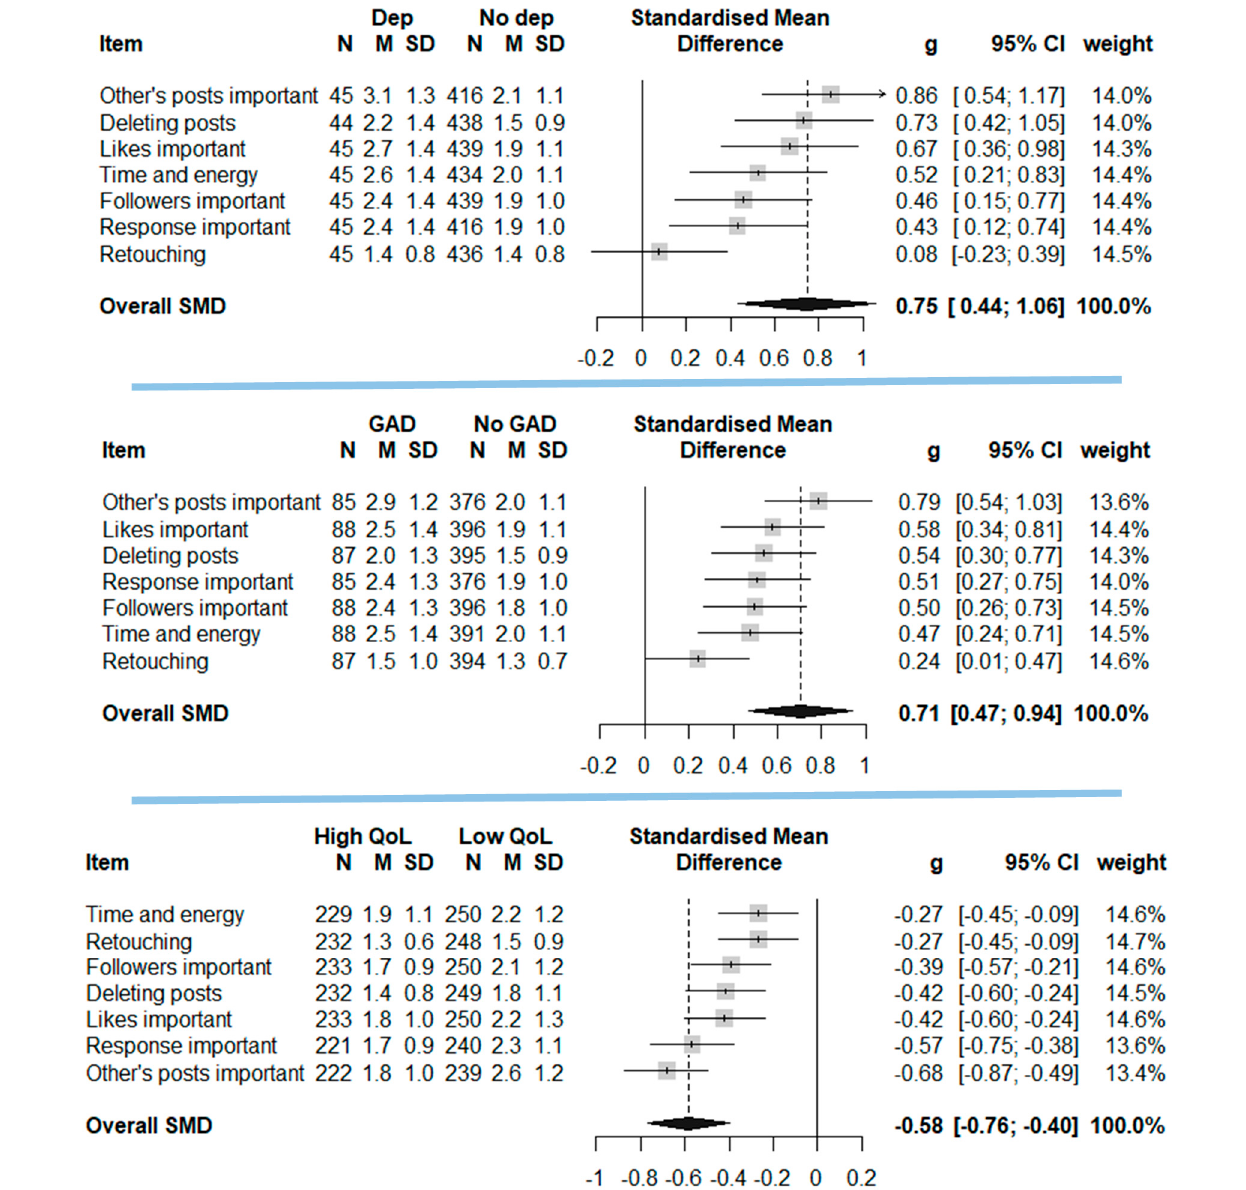
Figure 1. Associations between quality of life, depression and generalized anxiety, and self-reported focus on self-presentation on social media presented as blobbograms. Horizontal lines represent 95% confidence intervals, while the black diamond represents the overall standardized difference.